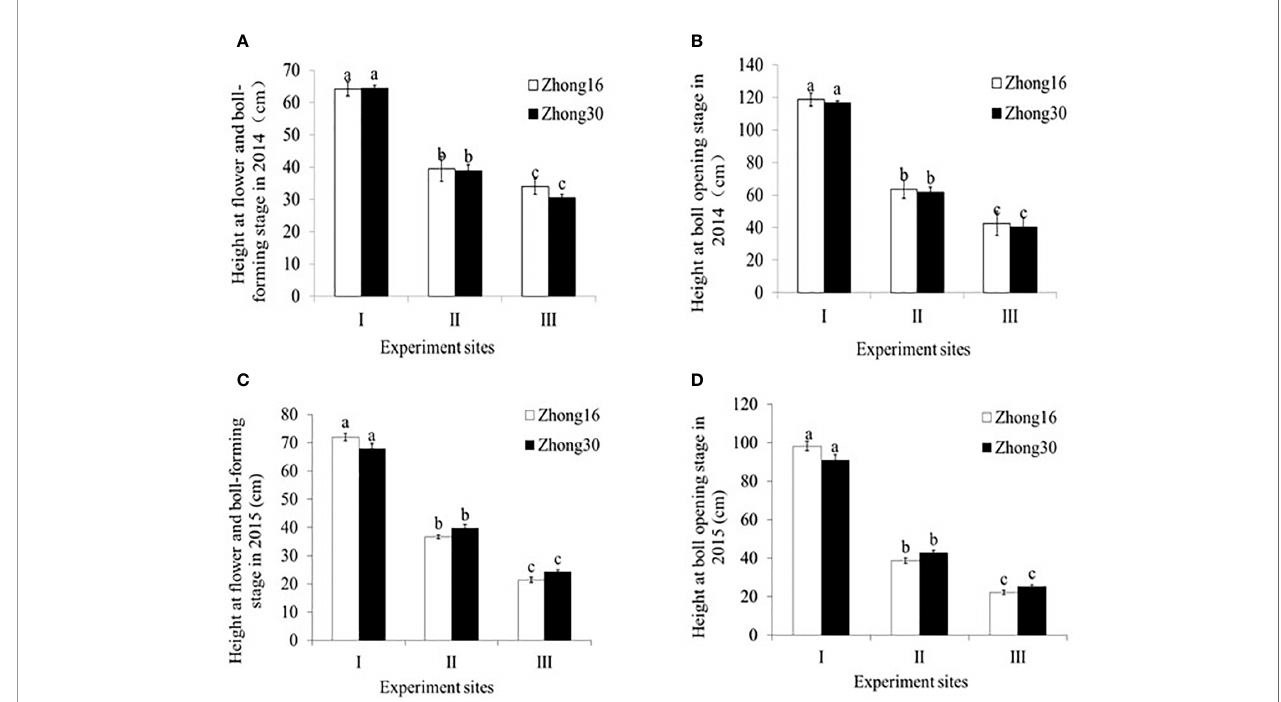
FIGURE 1 | Plant height (mean ± SEM) of Zhong30 and Zhong16 cotton plants grown under fi eld (I), grassland (II), and shrub (III) habitat at two stages in 2014 and 2015: (A) Flowering and boll-forming stage in 2014, (B) boll-opening stage in 2014, (C) fl owering and boll-forming stage in 2015, (D) boll-opening stage in 2015. Data followed by the same lowercase letters are not signi fi cantly different at 0.05